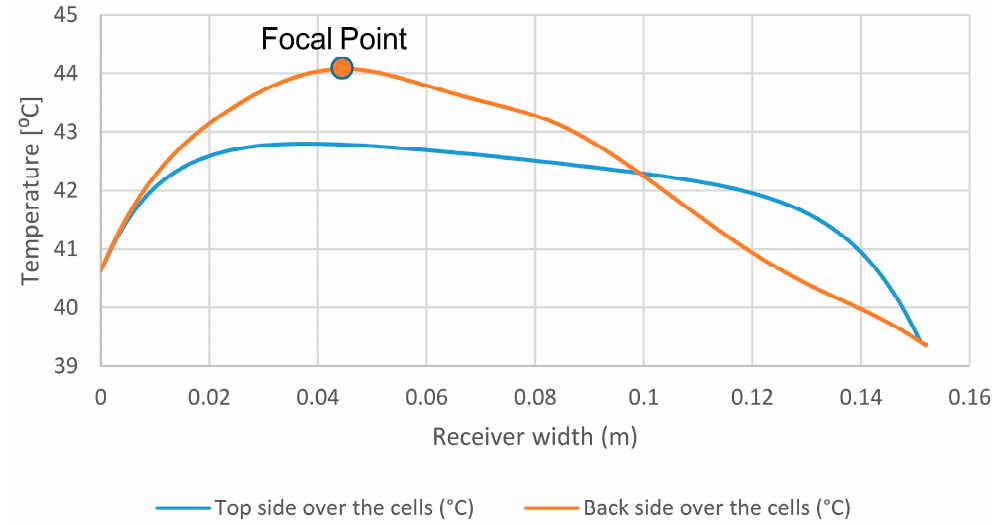
Figure 13. Simulated temperature distribution over the cells on both sides of the receiver (outer part) for measurement A.